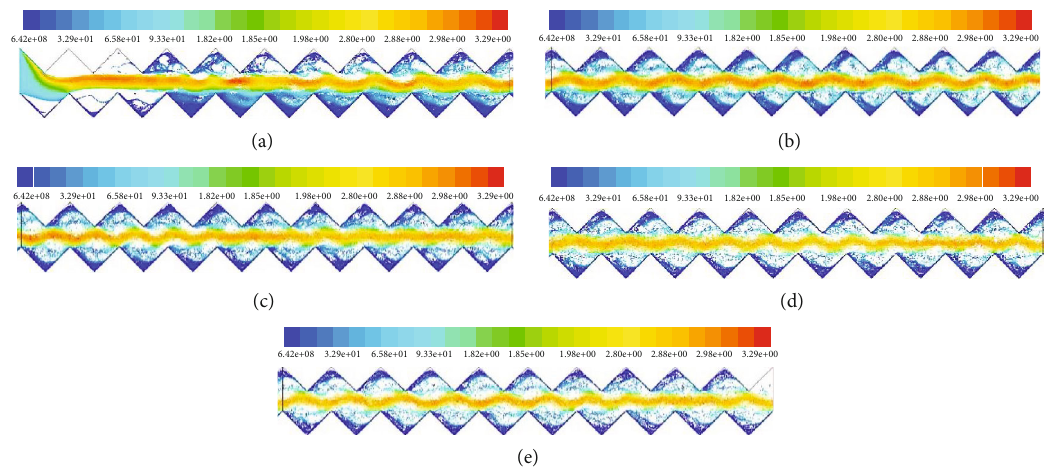
= 0 mm to X = 20 mm fracture segment; (b) X 1 1 = 60mm to X = 80mm fracture segment; (e) X 1 1